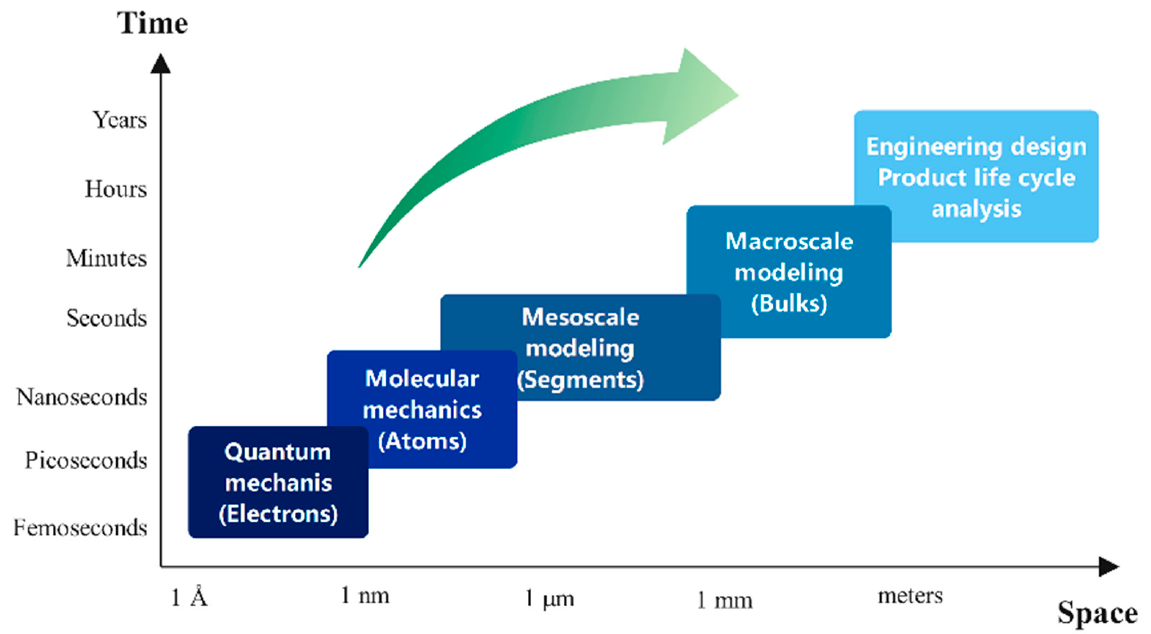
Figure 1. Spatial and temporal multiscale of polymer.